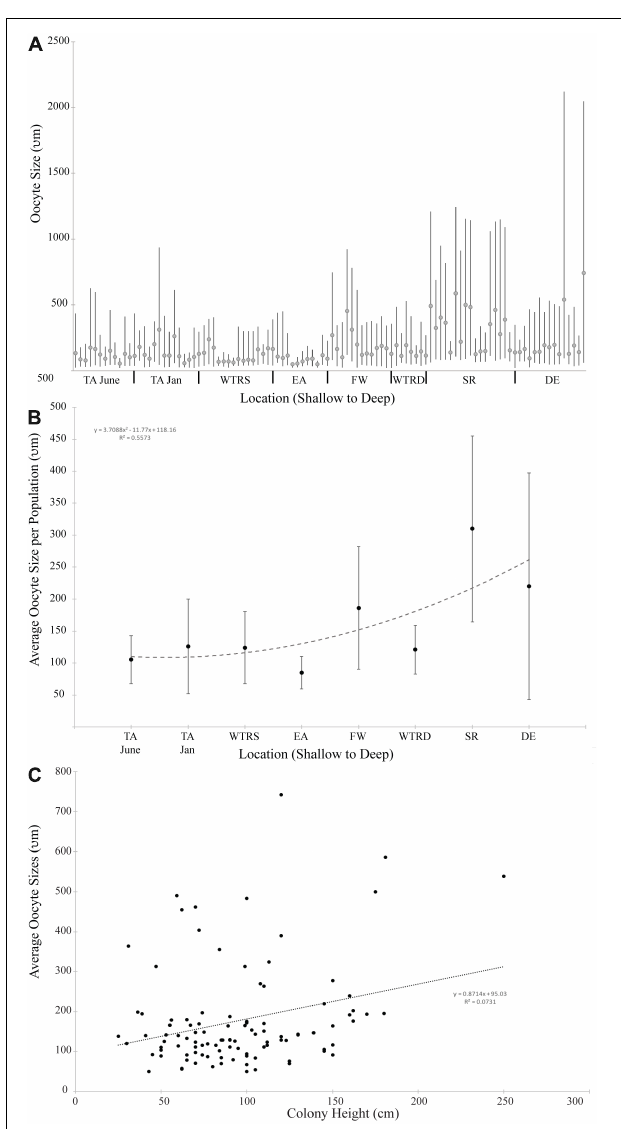
FIGURE 4 | (A) Oocyte size distribution for all females colonies at each study site. Bars delineate the minimum and maximum oocyte size for each colony; circles indicate mean oocyte size. (B) Average oocyte size plotted by location. The trend line is a second order polynomial; (C) Average oocyte size plotted by colony height for all females in this study. The trend line is linear. For (A,B) , sites are arranged from shallowest (left) to deepest (right).